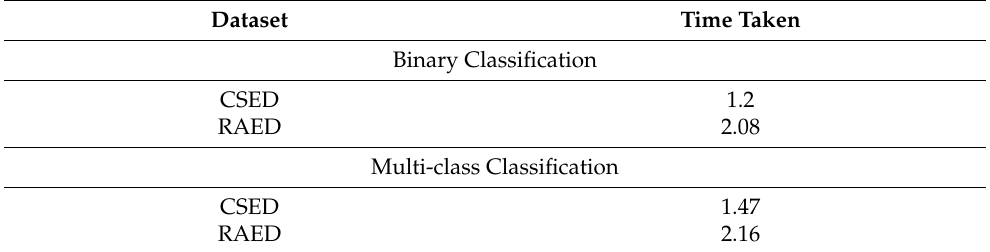
Table 8. Time comparison of different feature combinations.